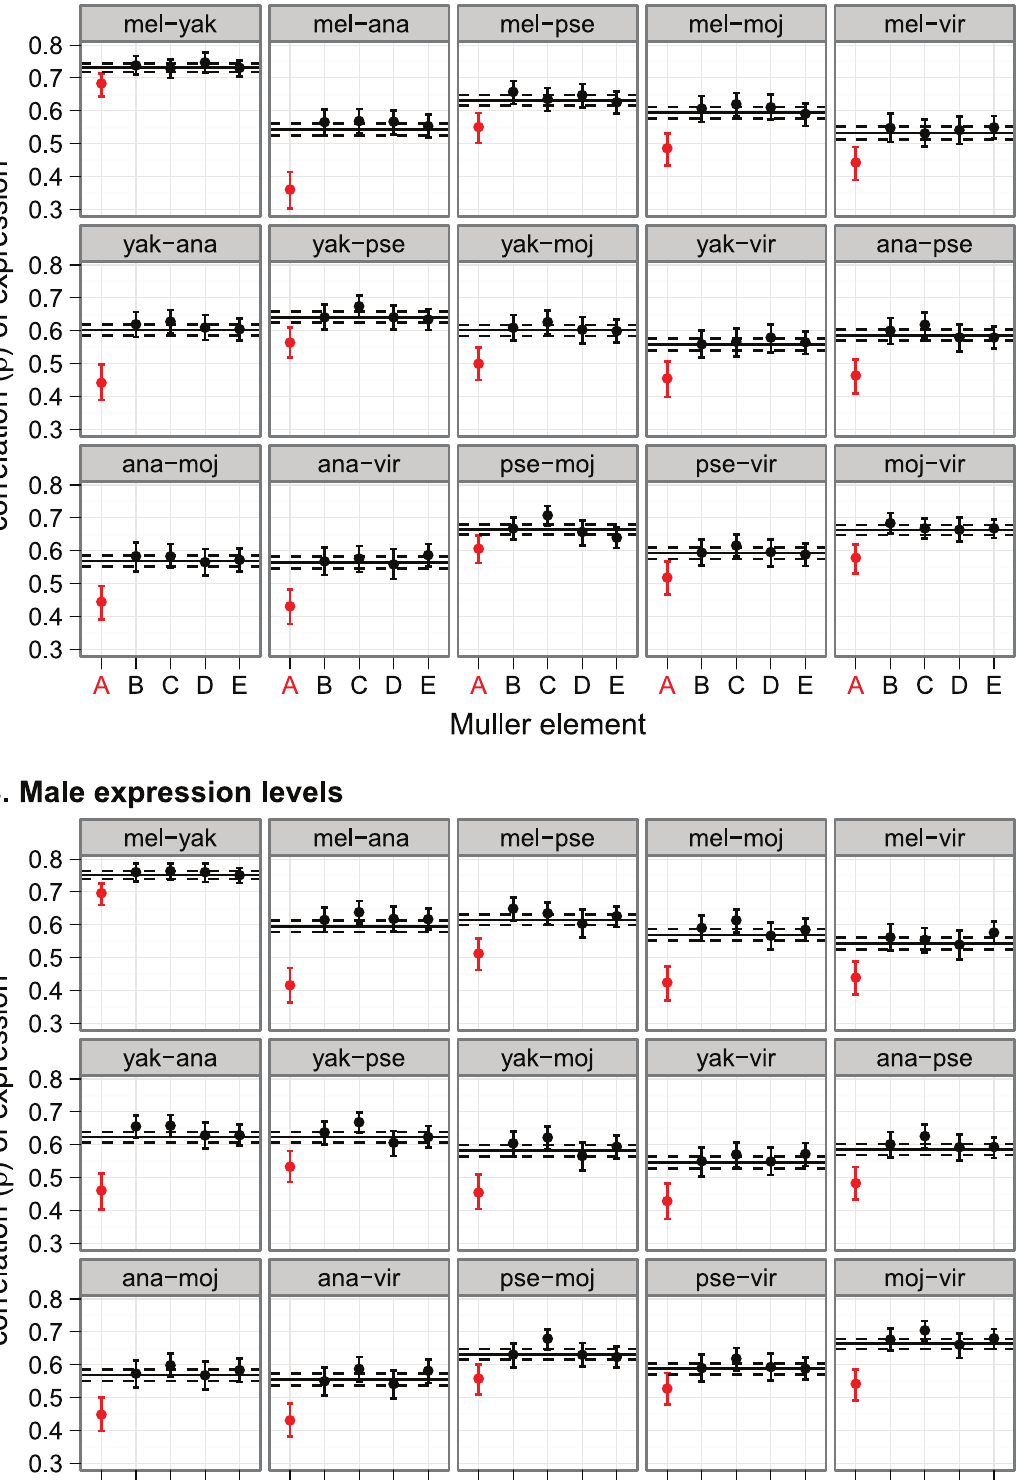
PLOS Genetics | www.plosgenetics.org 3 October 2012 | Volume 8 | Issue 10 |